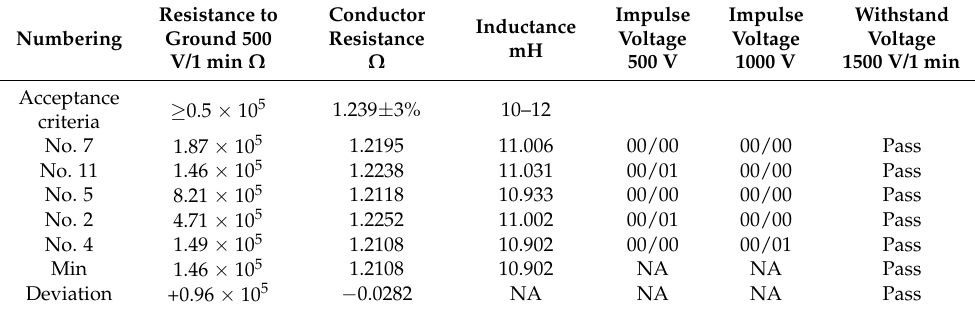
Table 4. The coil assemblies engineering verification